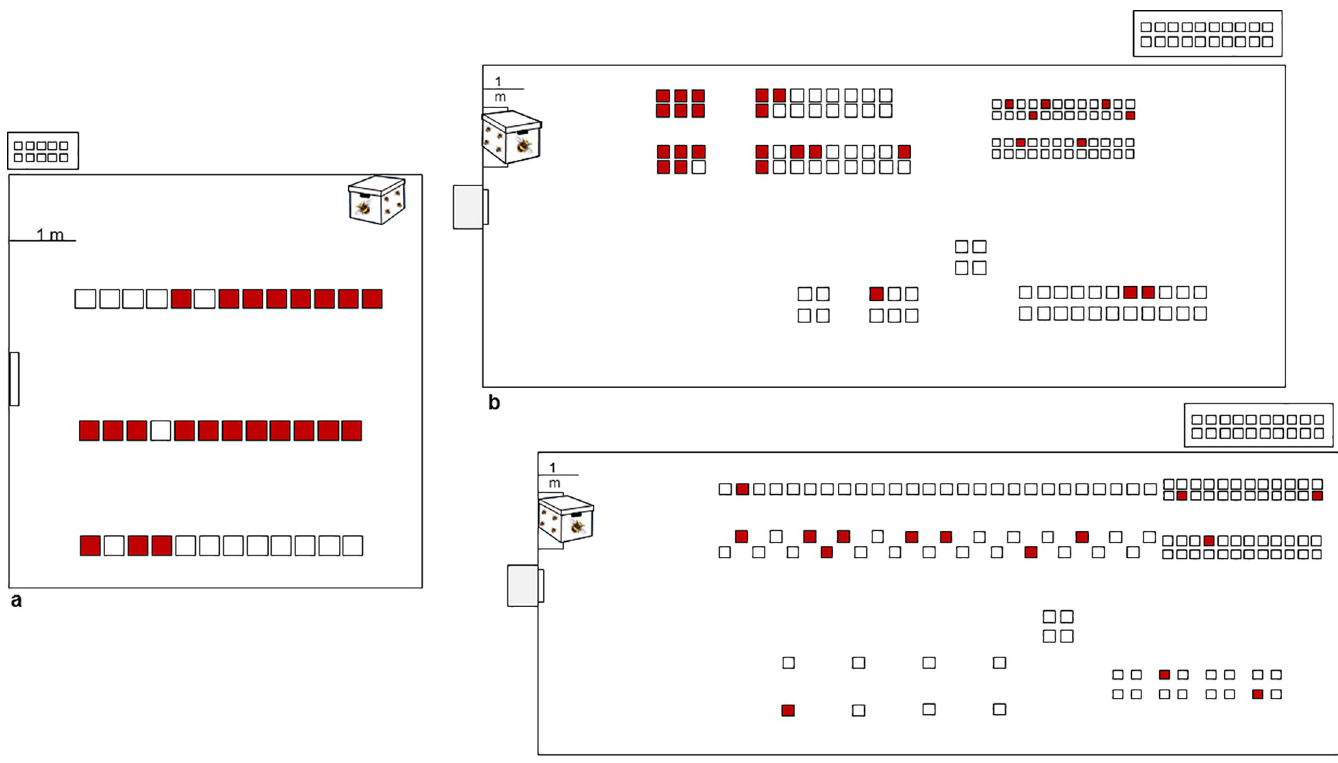
Fig 1. ToBRFV contaminated beehives spread viral disease. A schematic presentation summarizing the three glass-/net-house experiments using ToBRFV infected bumblebee hives. Adjacent to each experimental glass-/net-house is a depiction of a control experiment of tomato plants not exposed to the contaminated hives. a. A contaminated bumblebee hive inserted to a glasshouse of un-infected tomato plants cv. M82. b. A contaminated bumblebee hive inserted to a net-house of un-infected tomato plants cv. Ikram. c. A contaminated bumblebee hive inserted to a net-house of un-infected tomato plants cv. Ikram and Shiran. Red closed rectangles represent contaminated plants. Empty rectangles represent uninfected plants.